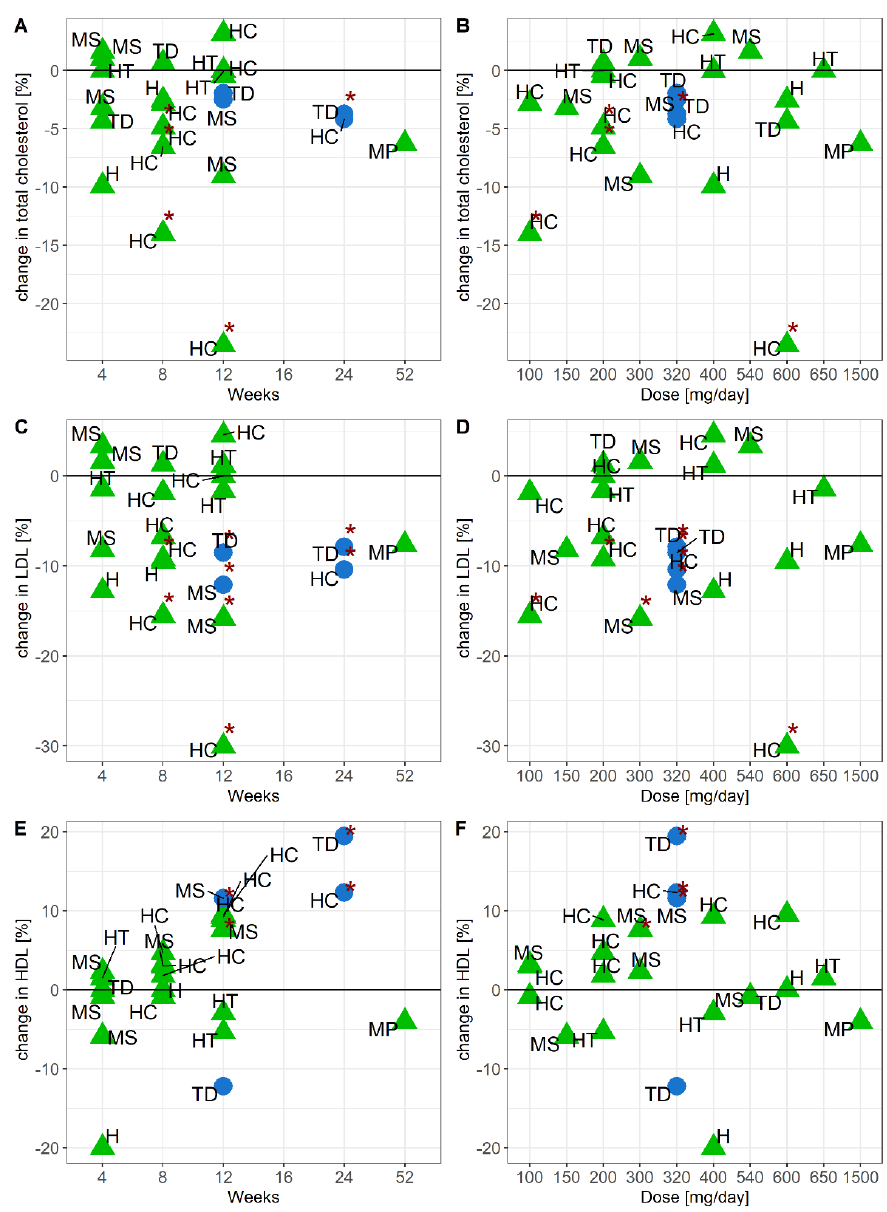
Figure 5. Relationship between total cholesterol and study duration ( A ), or dose ( B ), LDL cholesterol and study duration ( C ), or dose ( D ), HDL cholesterol and study duration ( E ), or dose ( F ). ● = bilberry and blackcurrant extract (blue), ▲ = grape seed extract (green), study population: H = healthy, HC = hypercholesterolemia, HT = hypertension, MP = mixed postmenopausal, MS = metabolic syndrome, TD = Type 2 Diabetes Mellitus. * published p -value < 0.05.